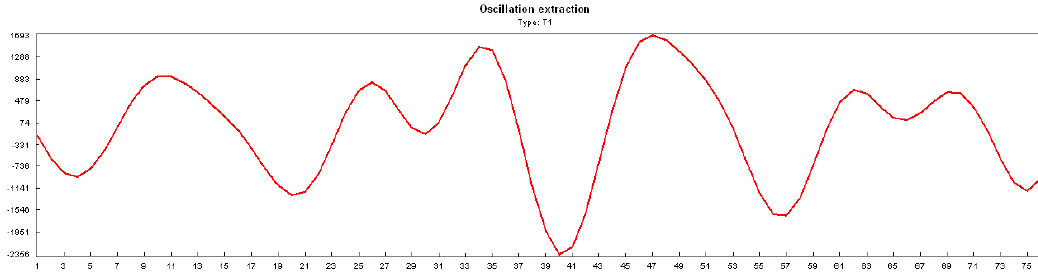
Figure 12. Harmonic from the eigentriples 4 to 9.